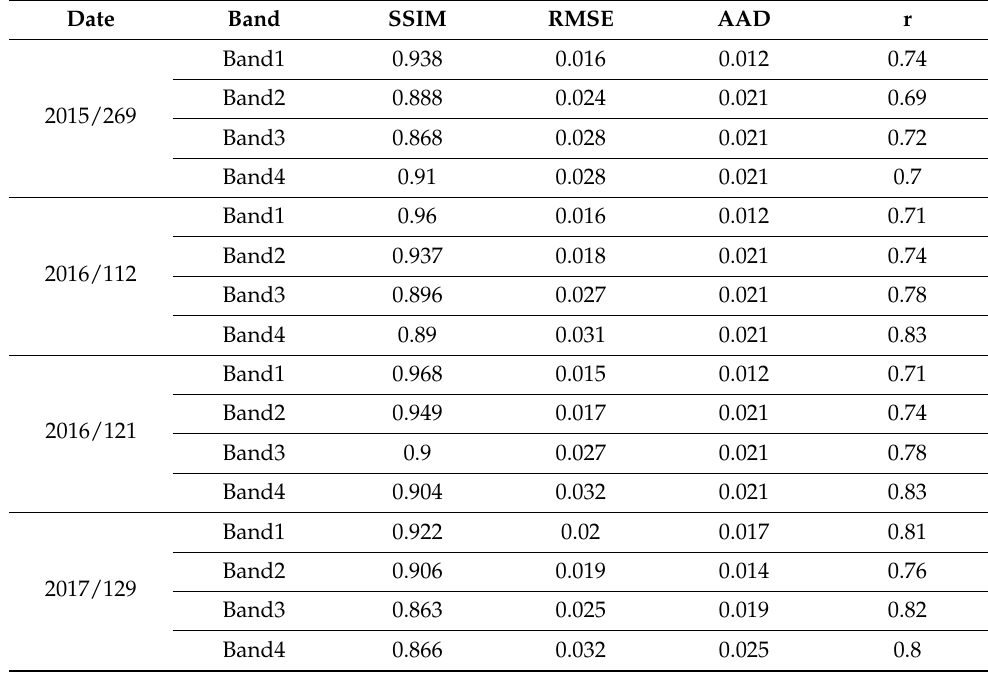
Table 2. The accuracy assessment of four fusion bands by ERTFM between the actual GF-1 images and predicted